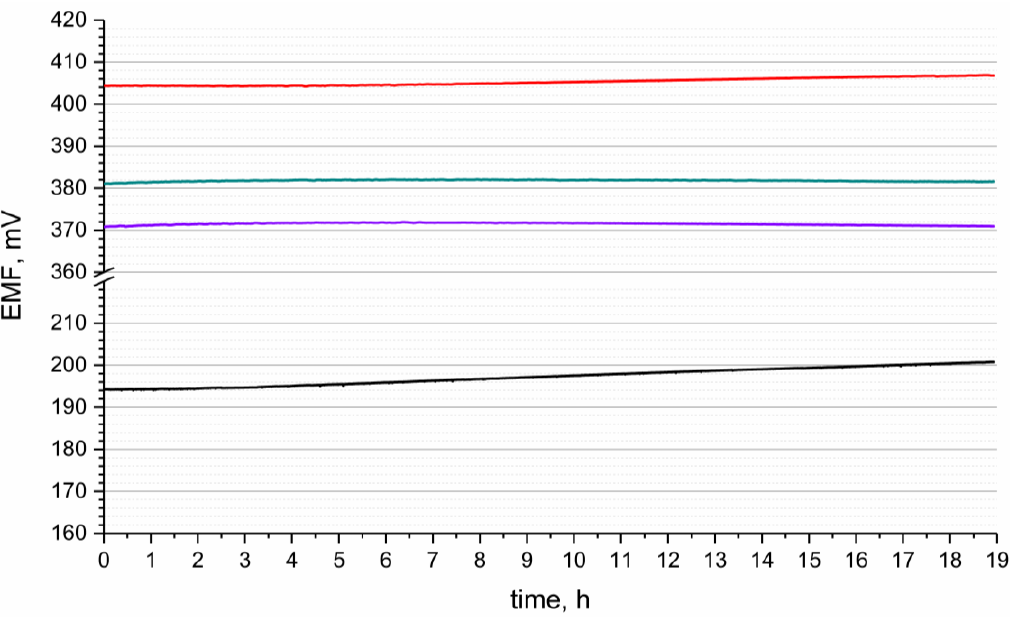
Figure 4. Potential stability of GC/hIrO 2 /H + -ISM (red line), GC/hIrO 2 +NTs/H + -ISM (green line), GC/hIrO 2 +NTs+POT/H + -ISM (purple line) and GC/H + -ISM (black line) electrode recorded in the buffer solution of pH 3.